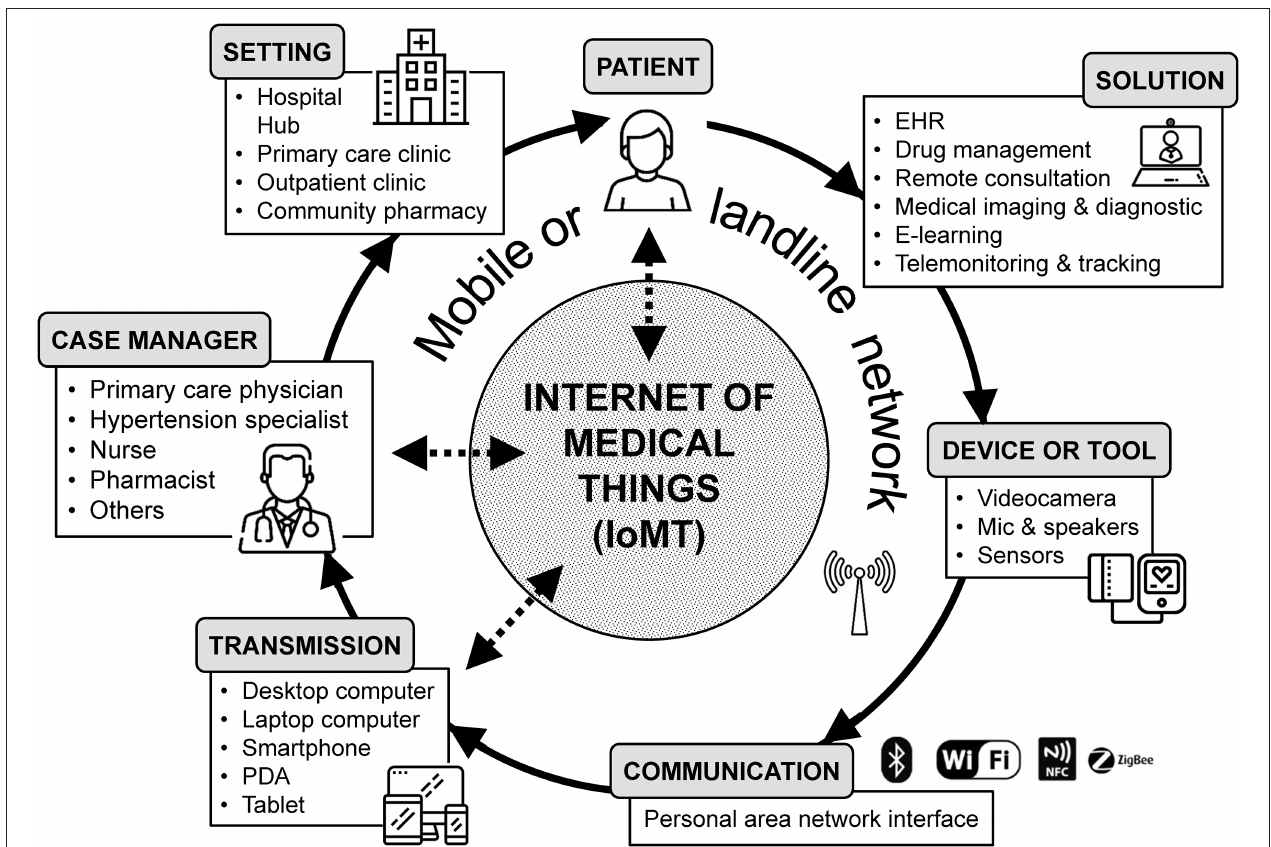
FIGURE 1 | Diagram of most common telehealth services and their workflow. EHR, Electronic Health Record; NFC, Near Field Communication; PDA, Personal Digital Assistant; IoMT, Internet of Medical